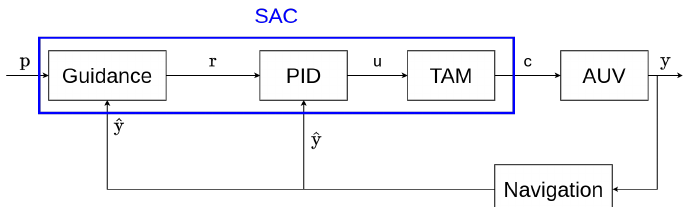
Figure 10. The components of the GNC system being replaced by the SAC-based